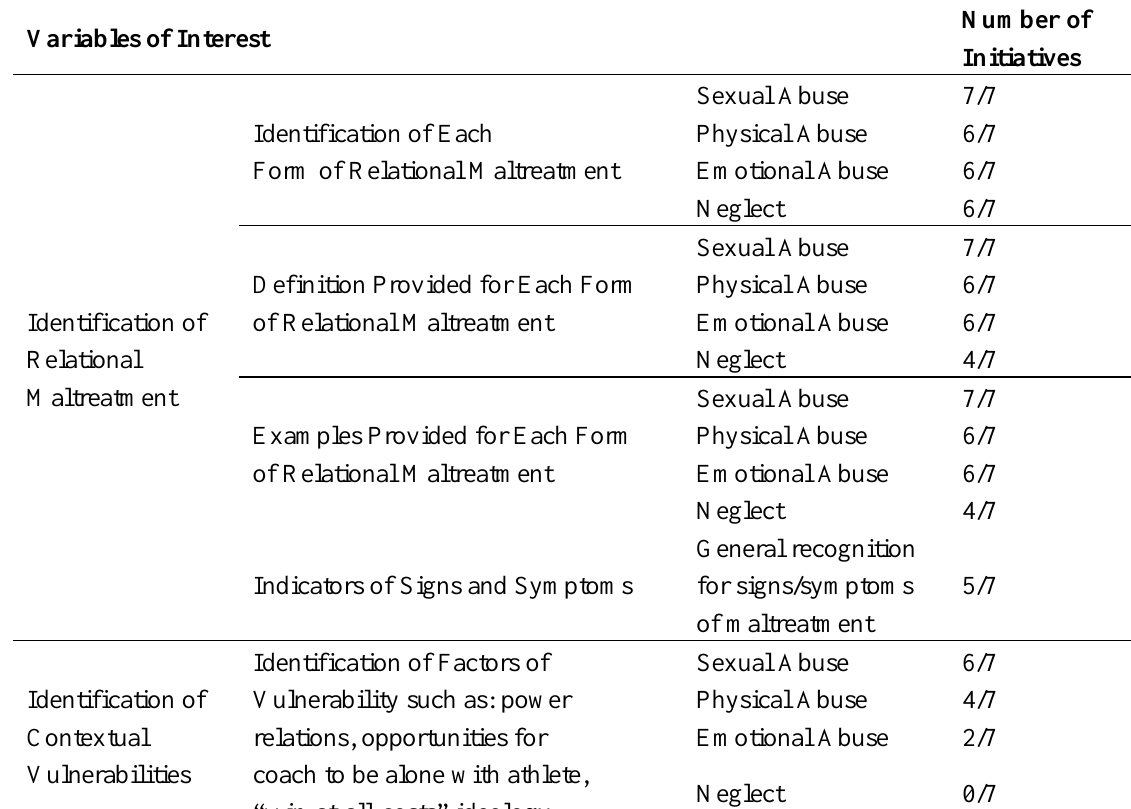
Table 2. Identification of